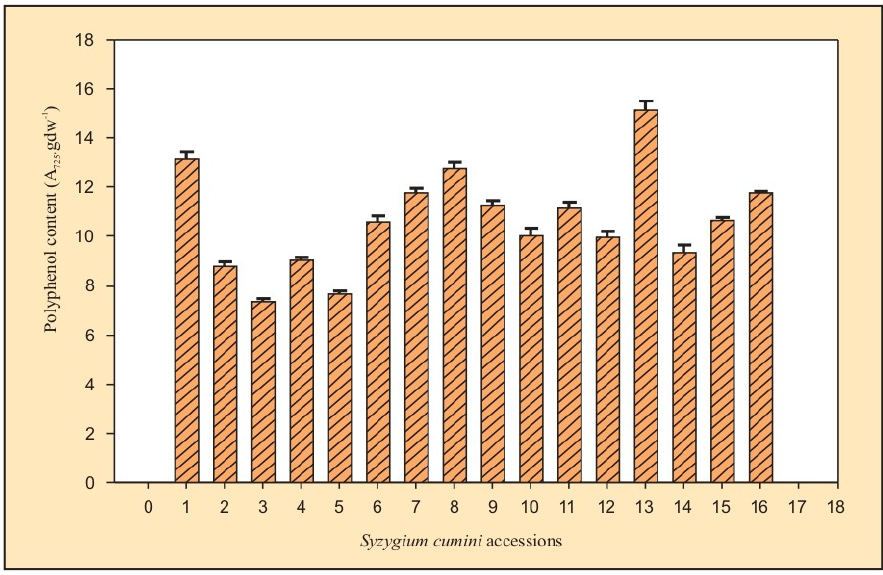
Figure 4. Total phenolic content in 16 S. cumini accessions. The total phenolics in the samples that belonged to semi-arid regions were 8.77, 7.38, 9.04, 7.65, 10.57, 11.74, 12.75, 11.25 OD units.gdw − 1 in Bhilwara, Kota, Jhalawar, Pratapgarh, Bhopal, Meerut, Banasthali, and Bangalore respectively. The total phenolics in the samples from the dry sub-humid region were 10.01, 11.12, 9.96, and 15.11 OD units.gdw − 1 in Saharanpur, Kanpur, Lucknow, and Varanasi, respectively. In the moist sub-humid region samples, the phenolic content was higher, i.e., 9.36, 10.62, and 11.77 OD units.gdw − 1 in Pantnagar, Nazibabad, and Roorkee, respectively. The polyphenol levels were particularly low in Pratapgarh, where total phenolics were only 7.65 OD units.gdw − 1